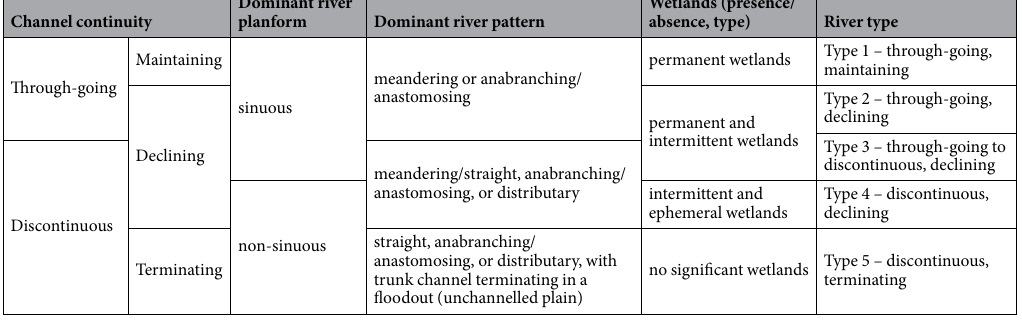
Table 1. Geomorphological measures used to differentiate the five dryland river